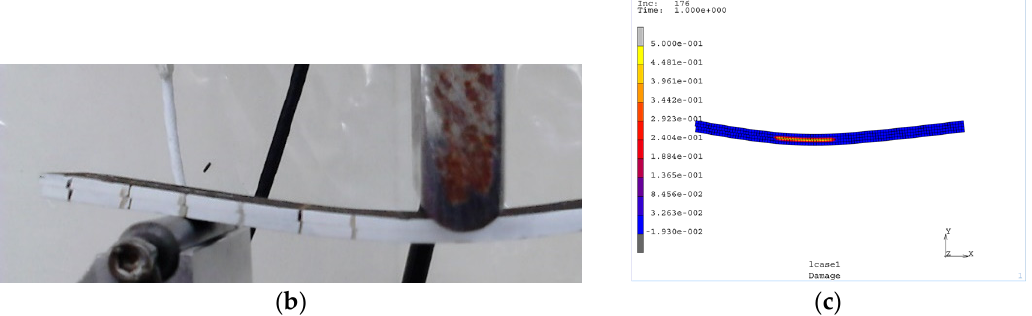
Figure 11. Mode II fracture test: ( a ) measured and predicted load vs. transverse displacement data; ( b ) typical deformed shape during test; ( c ) instance of crack propagation prediction.